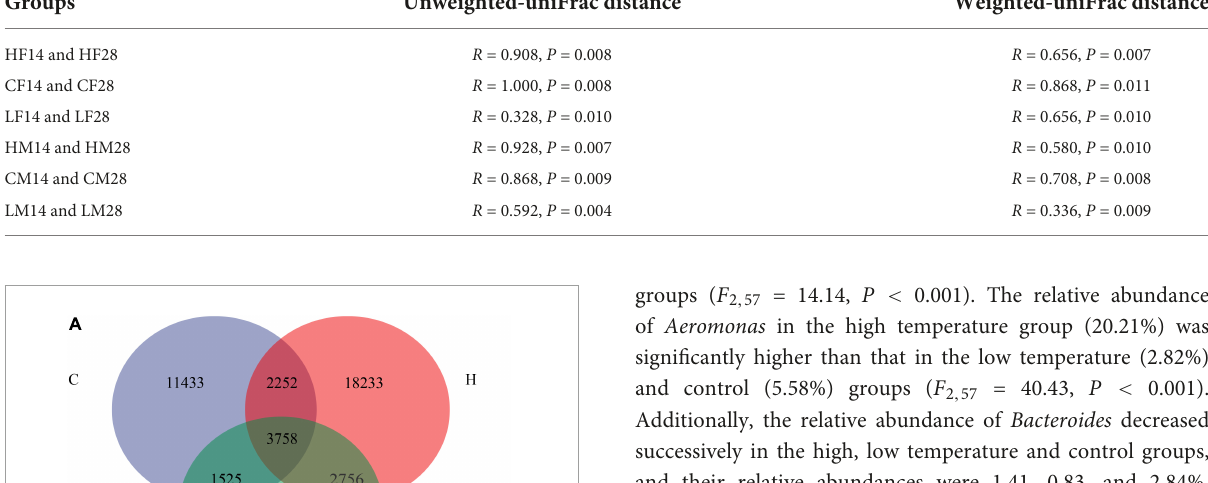
TABLE 3 Analysis of similarity (ANOSIM) analyses based on unweighted-UniFrac and weighted-UniFrac distances of Pomacea canaliculata intestine microbial communities at the different experimental time points.